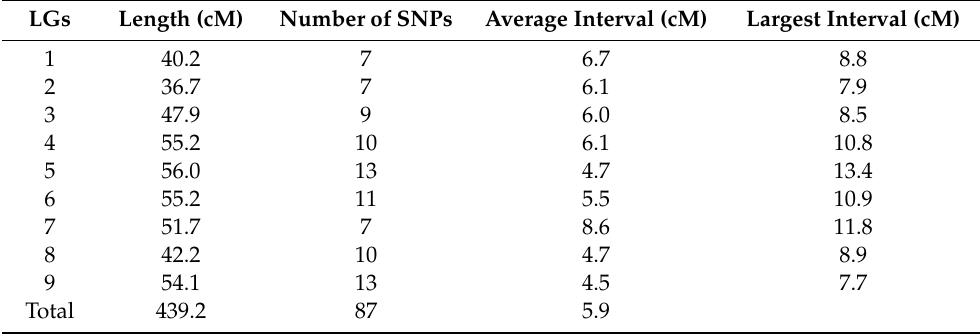
Table 1. Length, number of markers, average spacing, and largest intervals of GX50 genetic maps (LG; linkage group, SNP; single nucleotide polymorphism, cM; centi-Morgan).